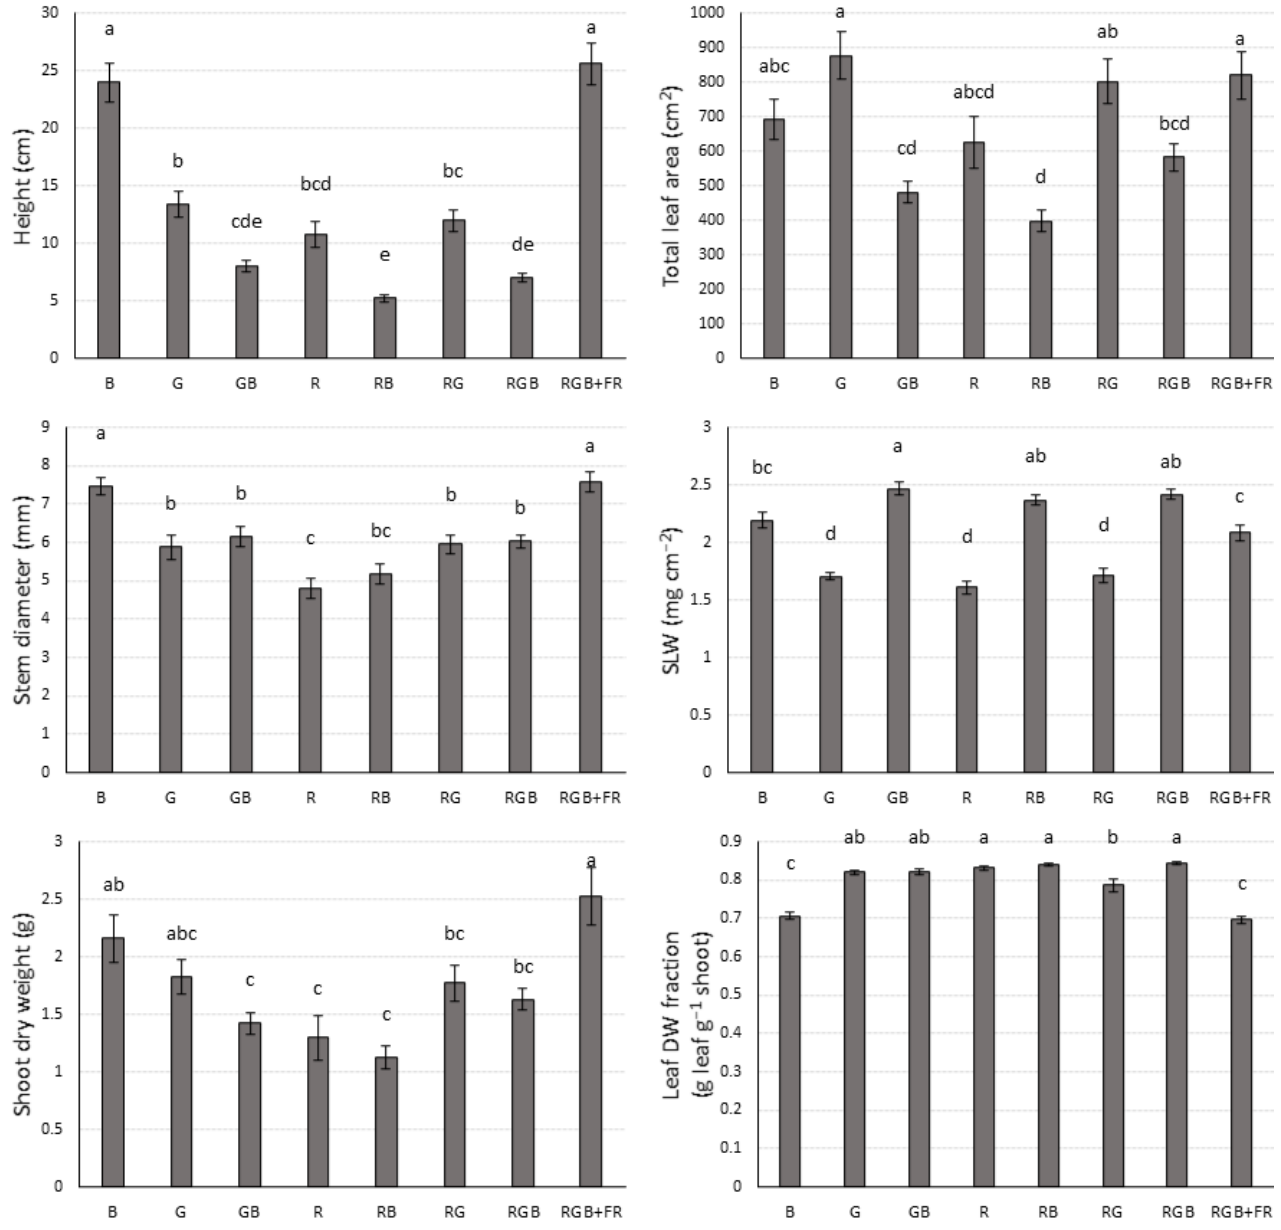
Figure 4. Shoot characteristics of cucumber under diverse spectra. Different lowercase letters indicate significant differences ( p ≤ 0.05; n is between 25 and 30 for each treatment). Uppercase letters indicate light treatments.